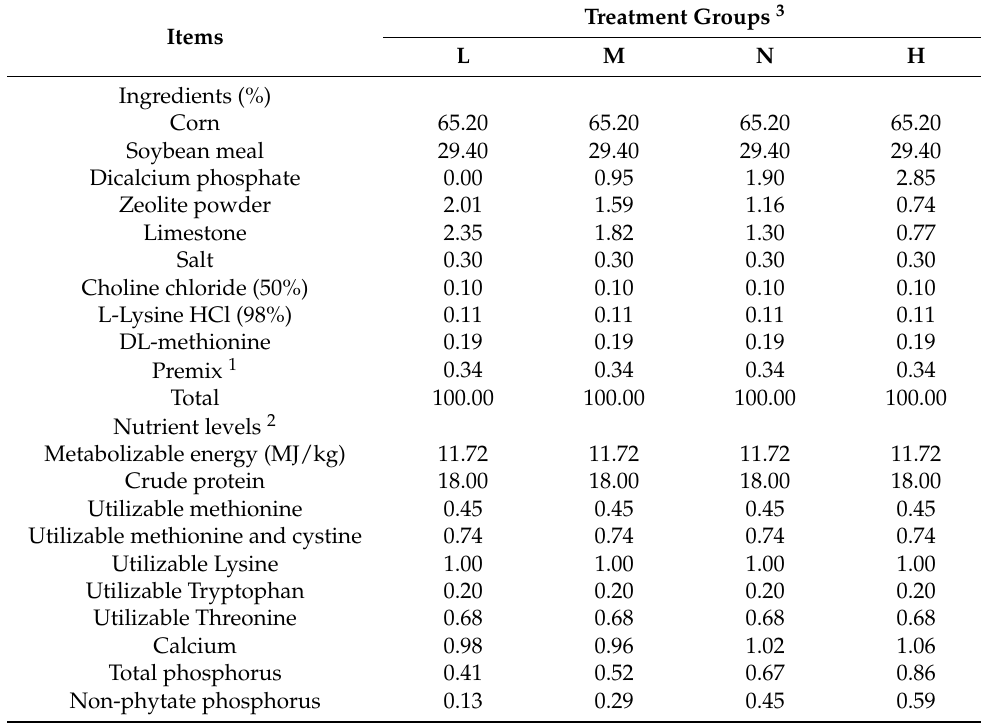
Treatment Groups